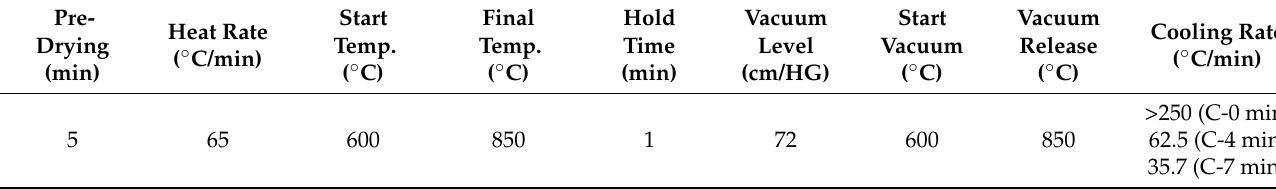
Table 2. Simulated glazing